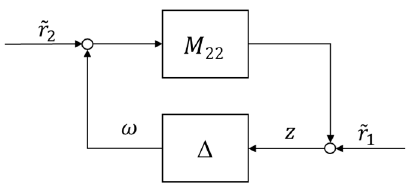
Figure 9. Block diagram of the linear fractional transformation.